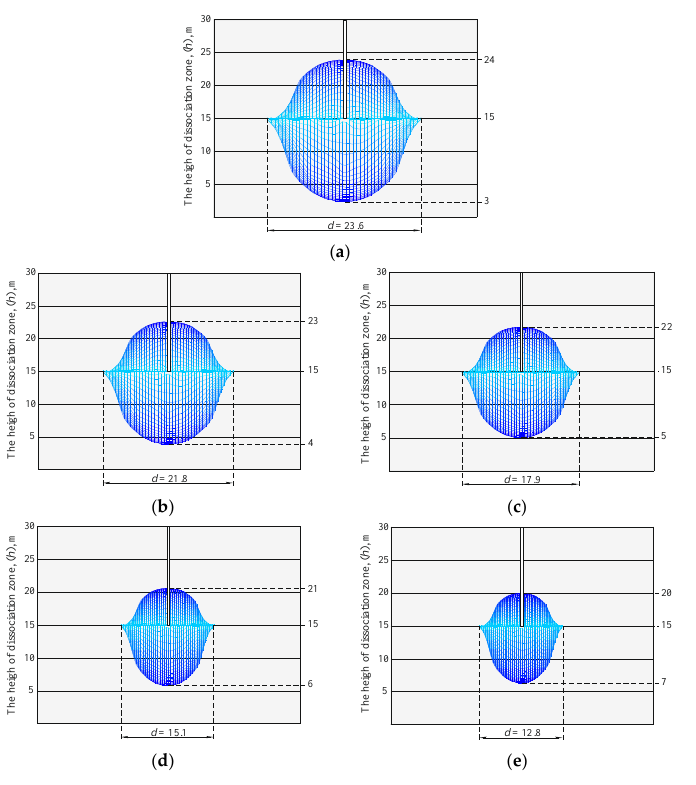
Figure 10. Dissociation zone cross-sections of the gas hydrate deposits with changing shares of rock intercalation: ( a ) 0%; ( b ) 15%; ( c ) 30%; ( d ) 45%; ( e ) 60%. With a 30% intercalation share, the dissociation zone diameter is 17.9 m, a reduction of 5.7 m in comparison with the prototype pure gas hydrate deposit. This share of rock intercalation is most typical for gas hydrate deposits and is most often found in nature. The gas recovery factor of this type of deposit during dissociation is intense and the vol- ume of methane gas output is 0.28 million m 3 . With an increase in the share of intercalation in the gas hydrate up to 45%, the dissociation zone diameter decreases by 8.5 m in com- parison with the gas hydrate deposit which does not contain rock intercalation at all, and its value is 15.1 m. The gas recovery factor for this zone is less, since almost half of the deposit contains rock intercalation, amounting to 0.13 million m 3 . The smallest diameter of dissociation zone is where the rock intercalation share is at 60%. This diameter is 12.8 m, which is almost two times less than the diameter present in the dissociation of the gas hydrate which does not contain any rock particles at all. The gas recovery factor during this dissociation is the lowest, amounting to 0.05 million m 3 . If the geometrical parameter values of the dissociation zones and their coordinate locations are known, the total volumes can be calculated. Having chosen the volume com- mand in the grid menu of the Surfer-8.0 software, with all the necessary spatial value pa- rameters of the coordinate points set previously, an automatic volume calculation is per- formed. The volume between two surfaces is the sum of the positive (cut) and negative